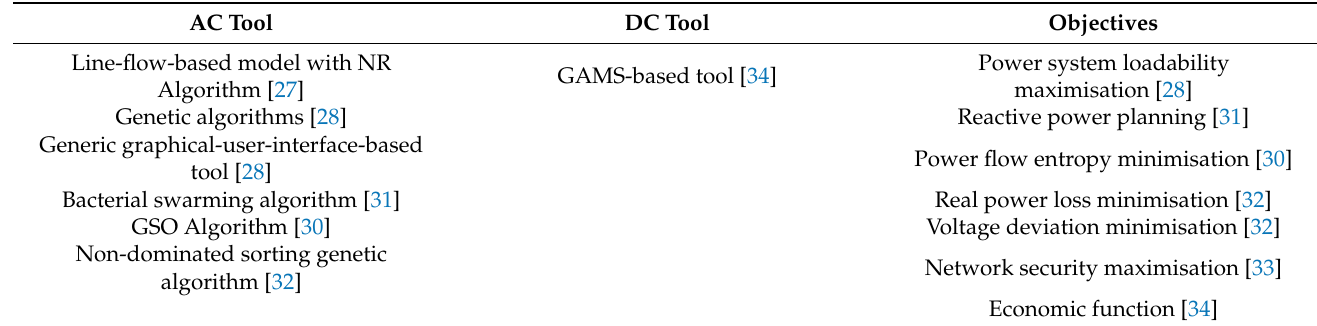
Table 1. Summary of optimal FACTS allocation